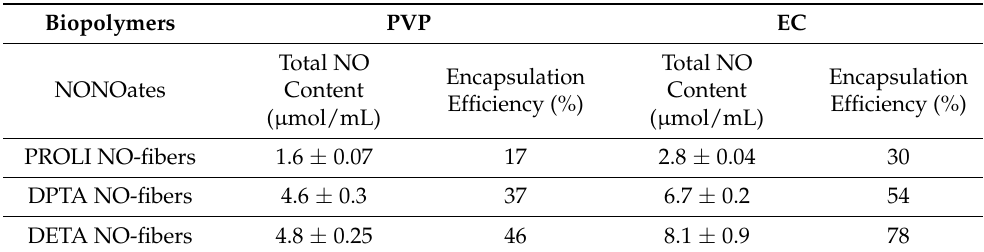
Table 1. Total NO content and encapsulation efficiency for PVP and EC NO-fibers prepared with various NONOates in this